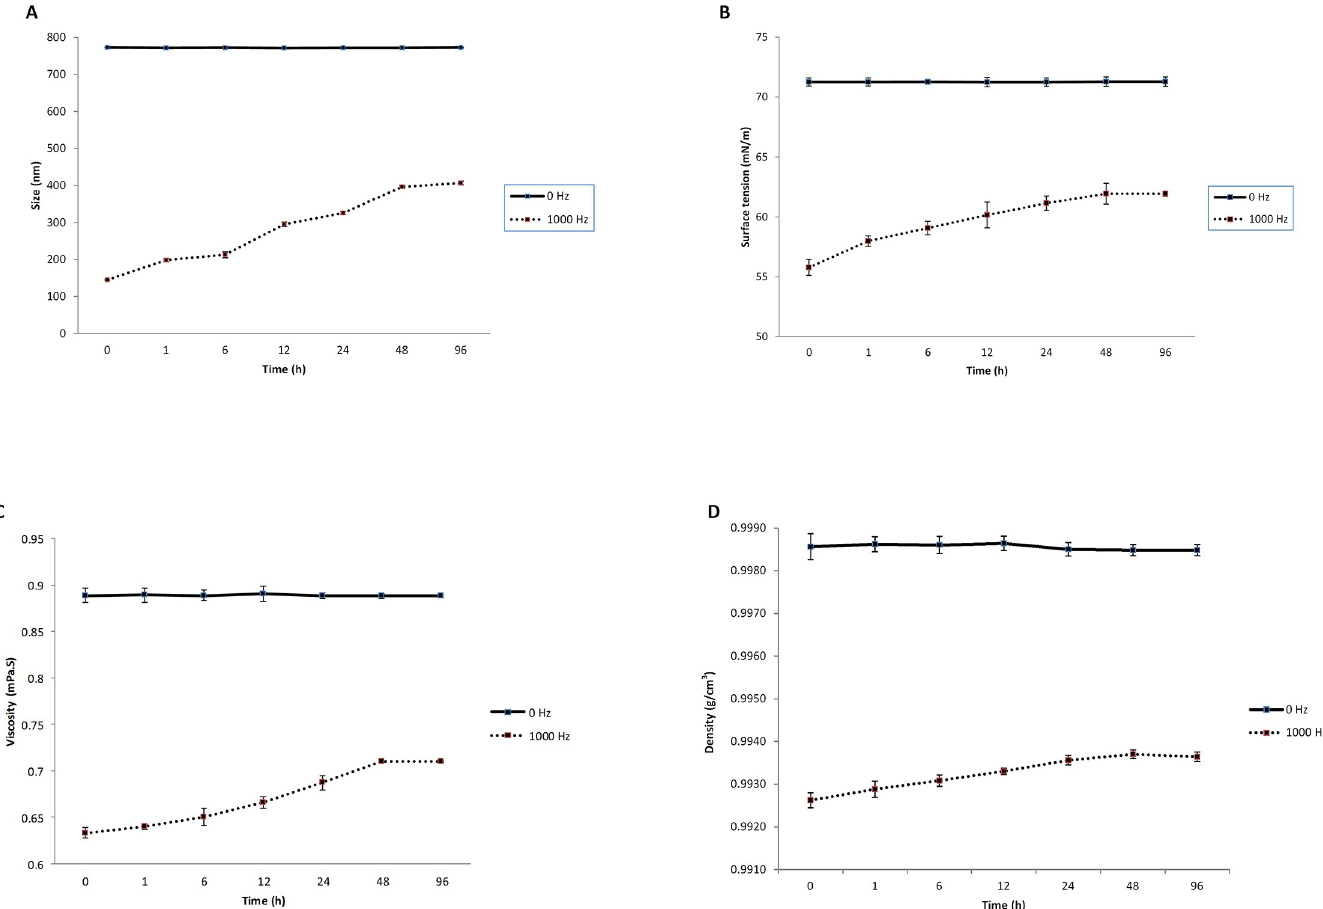
Fig 2. The memory effect of electromagnetized water. (A) Cluster size analysis. (B) Variation of the dynamic surface tension. (C) The viscosity of water. (D) The density of water. In all sub-graphs the physicochemical properties of water do not return to the point before applying 1000 Hz ELEF. Values are expressed as mean ± SD; n = 5. P-values were adjusted by Bonferroni for multiple comparisons at 0.001 significantly level.